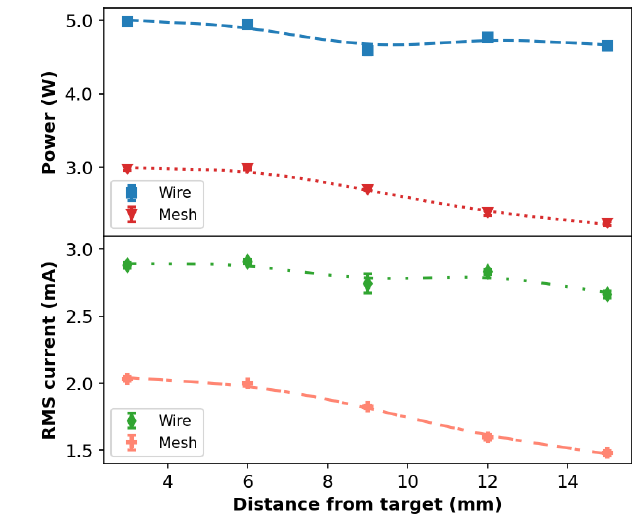
Figure 4. Discharge power and effective current as a function of the distance between plasma outlet and target obtained with a gas flow rate of 2.0